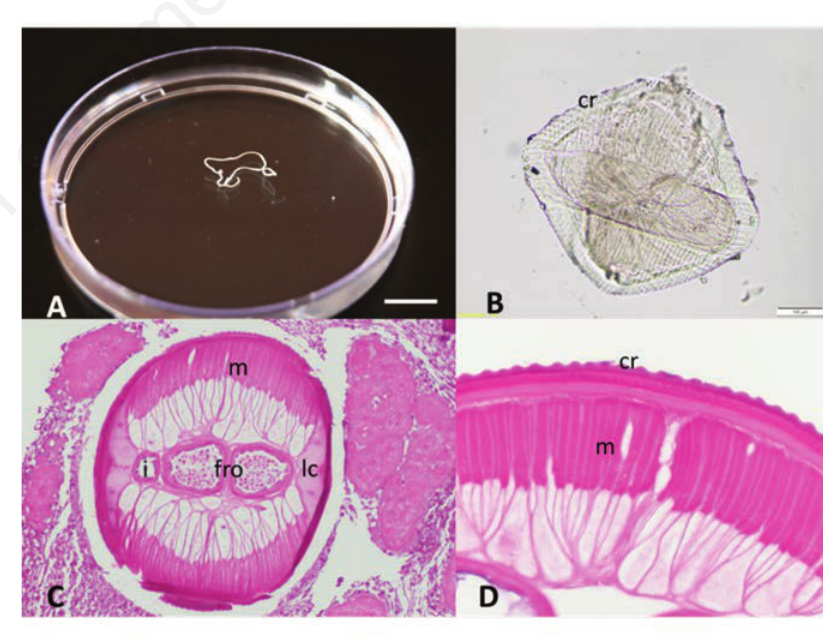
Figure 2. A) Case 1. Macroscopic view of filarial nematode. Bar=15 mm. B) Case 1. Transverse section of nematode, unstained, showing cuticular ridges (cr). Bar=0.1 mm. C) Case 2. Transverse section of nematode, H&E stain, showing coelomyarian mucles cells (m), lateral chords (lc), female reproductive organs (fro), and intestine (i). Original magn. 100×. D) Case 2. Transverse section, H&E stain, showing coelomyarian muscle Figure 1. Cystic lesion on inferomedial cells (m) and prominent cuticular ridges (cr). Original magnification aspect of the left eye.